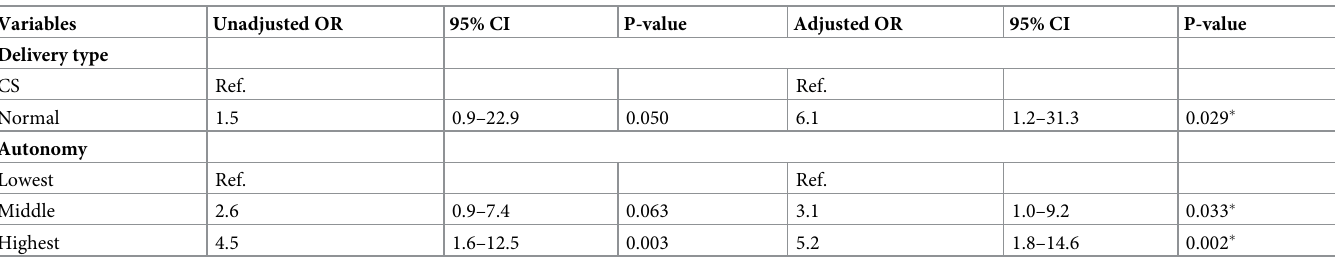
Table 5. Factors associated with exclusive breastfeeding.